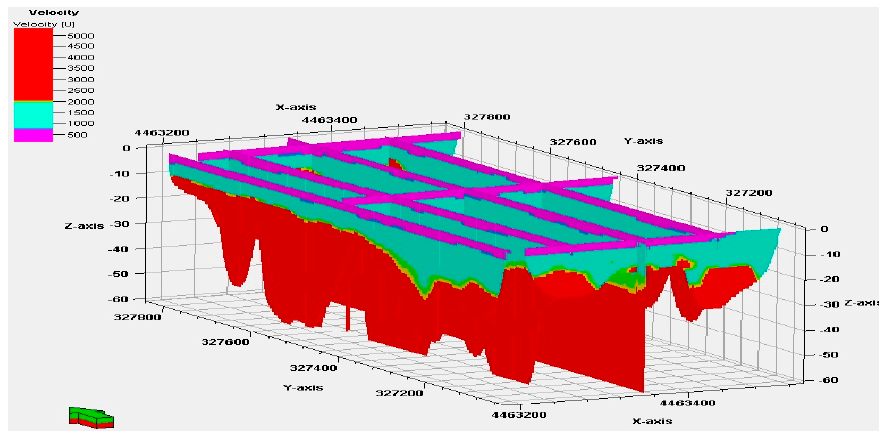
Figure 15. Upscaled velocity attribute into the 3-D grid. Cells intersecting the upscaled dataset are given the respective value which are then interpolated during petrophysical modeling.